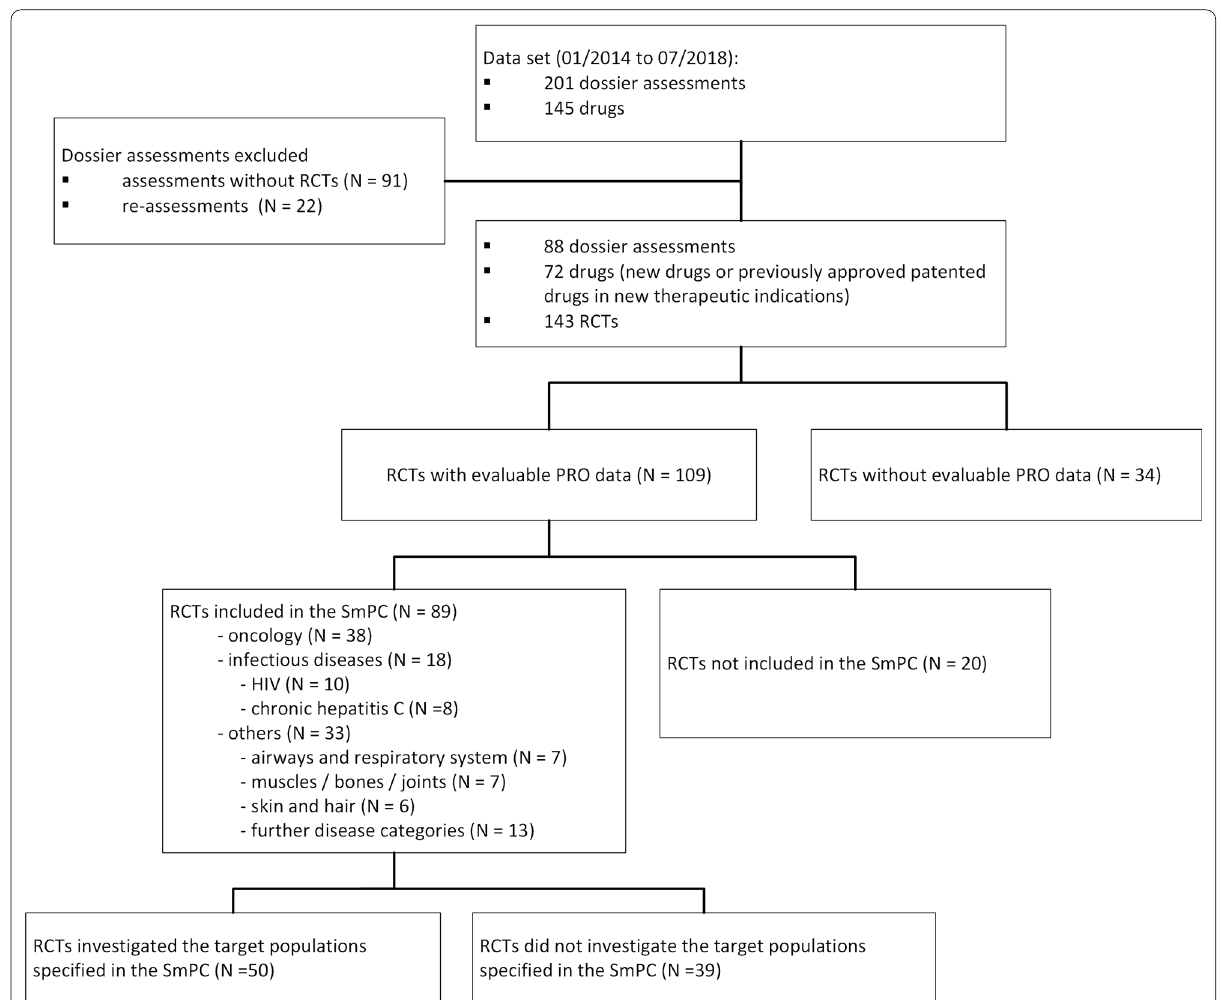
Fig. 1 Flow chart of the data set included. HIV human immunodeficiency virus, N number of RCTs, PRO patient-reported outcome, RCT randomized controlled trial, SmPC summary of product